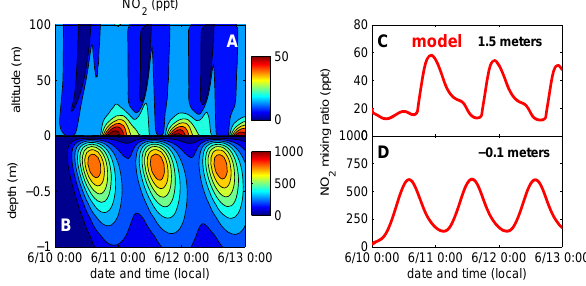
Fig. 6. Modeled NO 2 mixing ratios in the atmosphere (A) and in- terstitial (B) air. Modeled mixing ratios in the atmosphere at an altitude of 1.5m above the snowpack are shown in panel (C) , NO 2 was not measured during the field campaign. Predicted interstitial air mixing ratios 10cm below the snow surface are shown in (D)